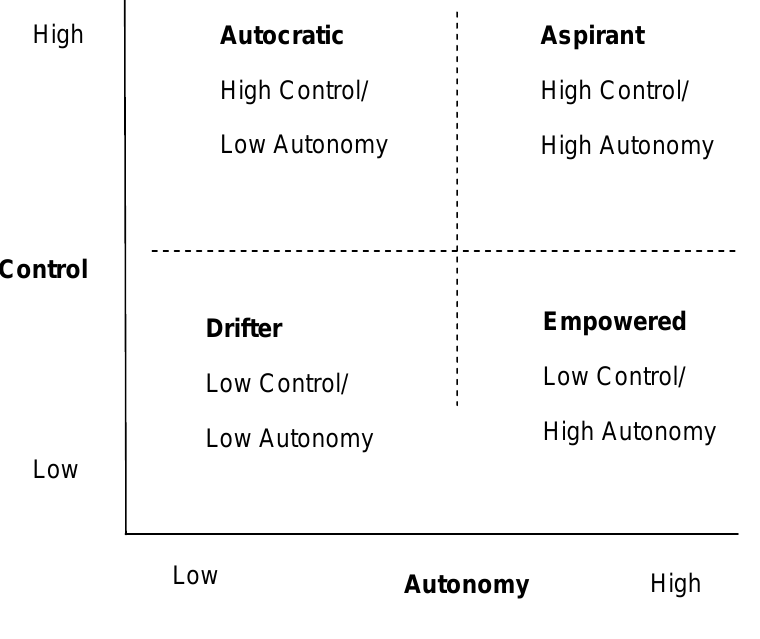
Figure 3: The autonomy and control interdependence